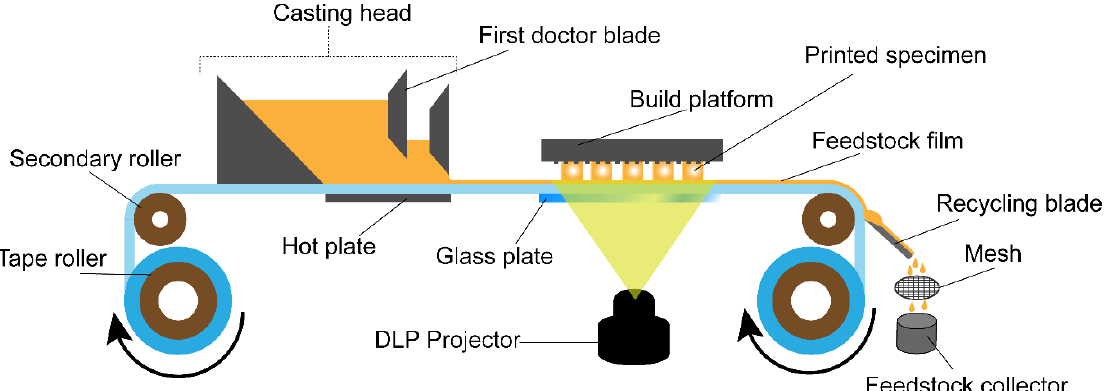
Figure 1. Schematic of the continuous film supply system with digital light processing during the three-dimensional printing process.